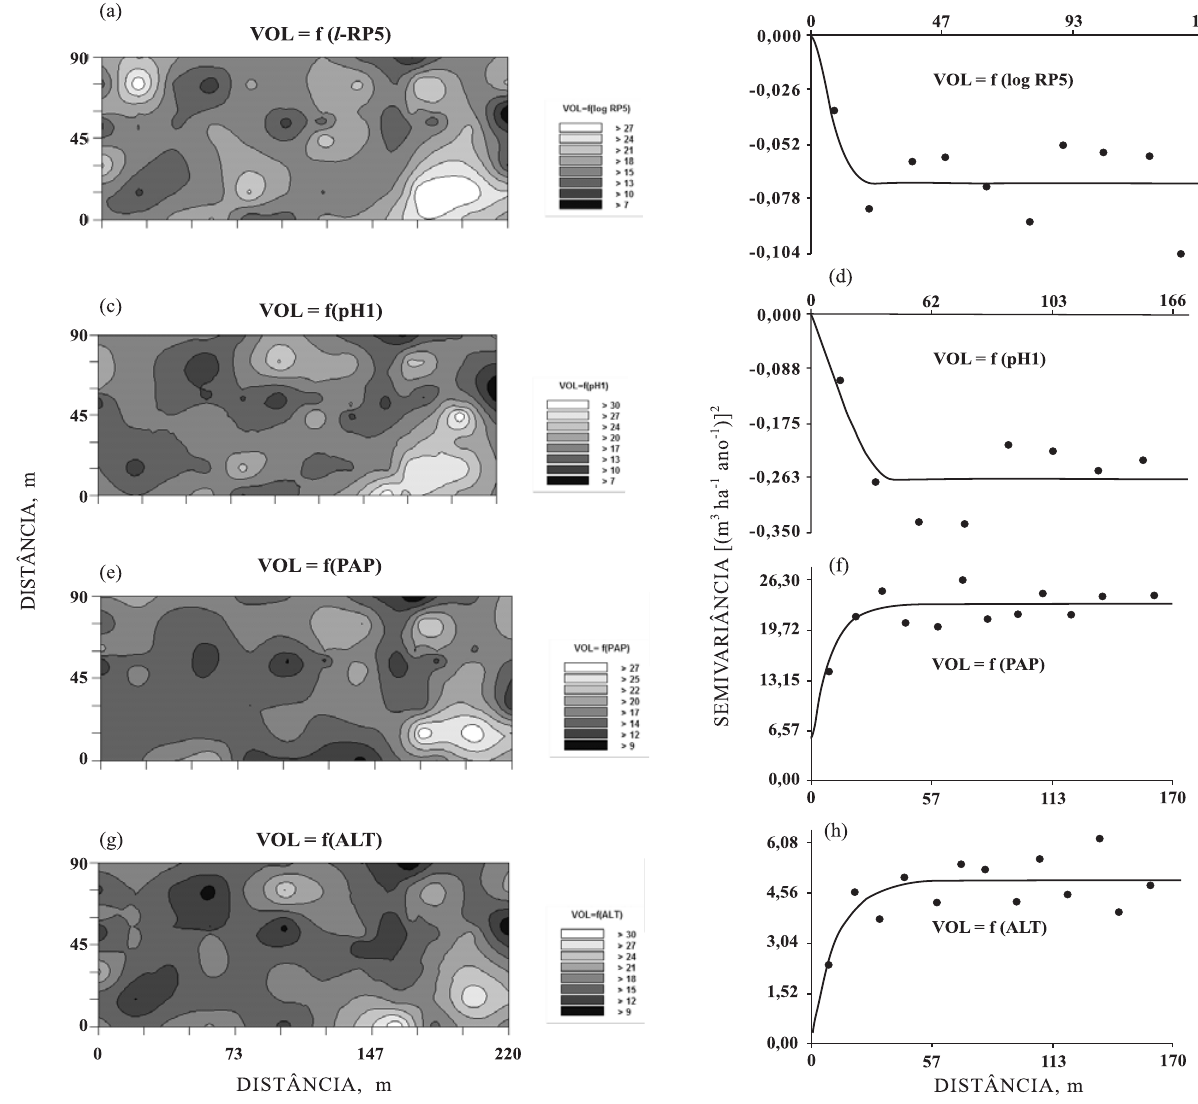
Figura 1. Mapas de cokrigagem e semivariogramas cruzados entre o volume de madeira do Eucalyptus camaldulensis com as características da planta (PAP e ALT) e o l -RP5 e pH1 de um Latossolo Vermelho distrófico de Selvíria